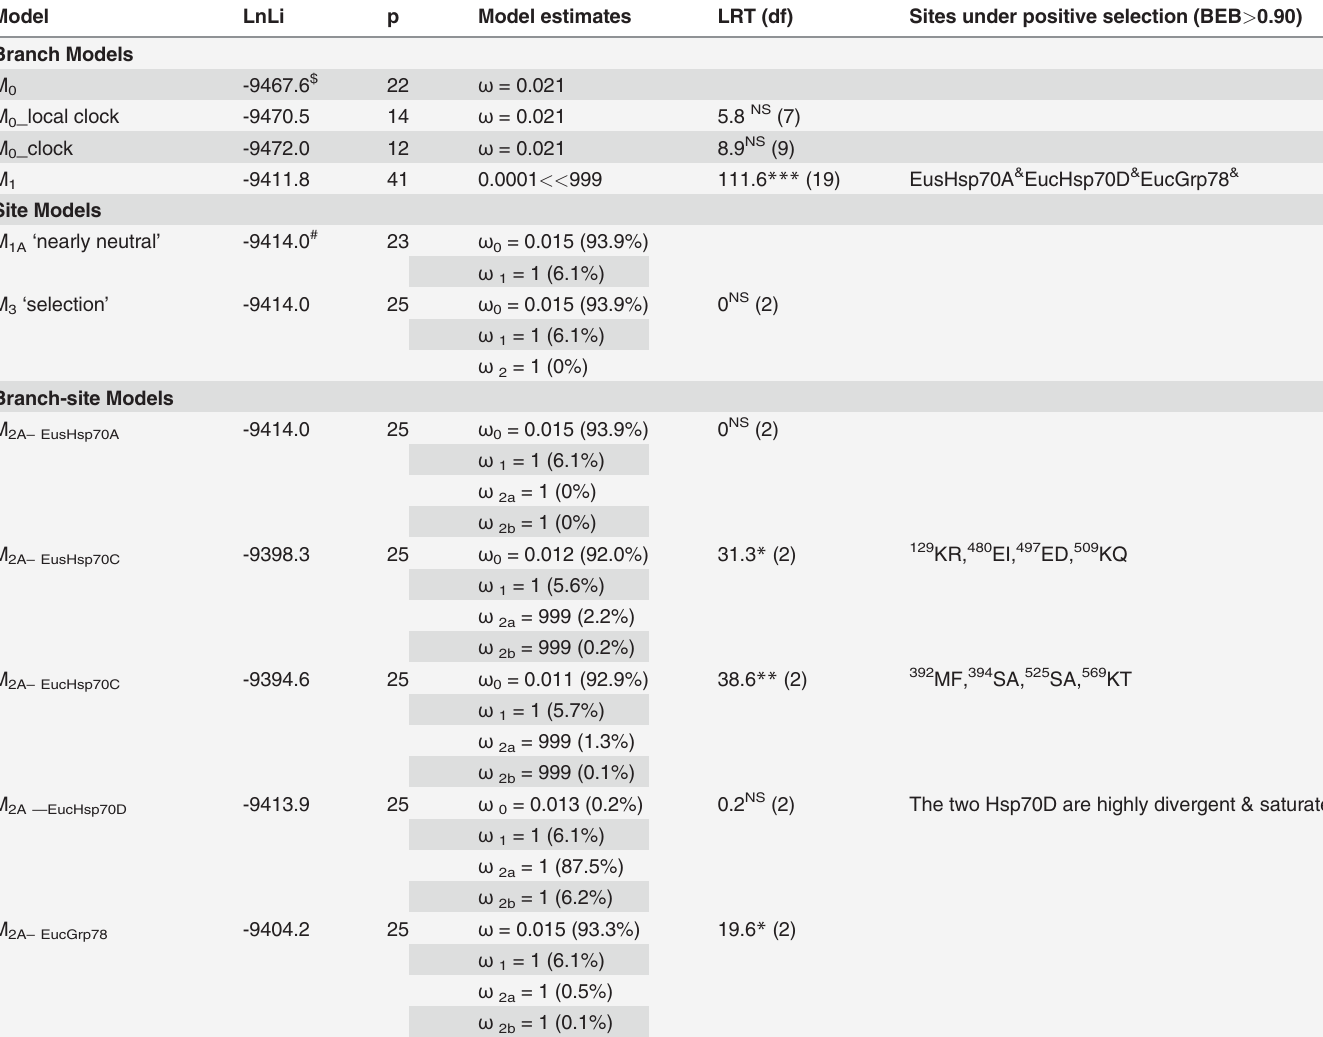
Table 2. Parameter estimates of the selection models implemented in the CodeML package of PaML vs 3.44 [31], likelihoods (LnLi) and associated likelihood ratio tests (LRT). Model LnLi p Model estimates LRT (df) Sites under positive selection (BEB >